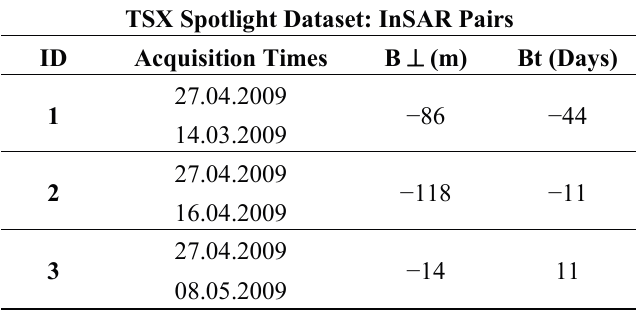
Table 1. List of the three interferometric pairs, obtained from the four spotlight acquisitions, used for frequency-persistent scatterers (FPS)